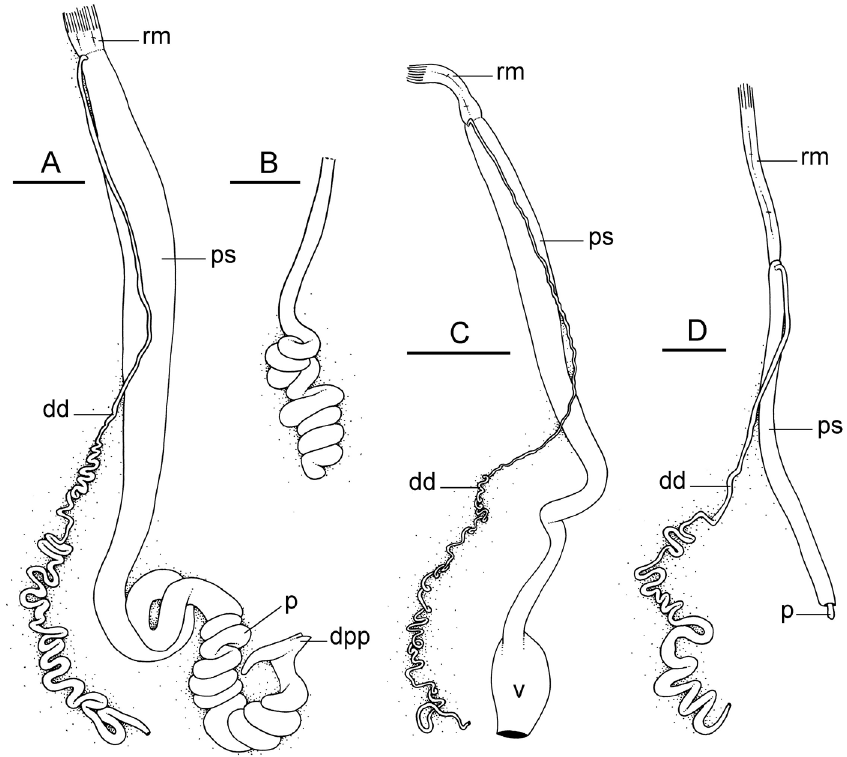
Figure 40. Reproductive system, Wallaconchis ater , Indonesia. A Anterior, male copulatory parts (ves- tibule removed, showing the coiled and U-shaped penis), Halmahera, scale bar 2 mm [5078] (UMIZ 00047) B Penis (coil of loops removed from vestibule), Sulawesi, scale bar 2 mm [2283] (UMIZ 00038) C Anterior, male copulatory parts, scale bar 5 mm, same as B D Anterior, male copulatory parts, Kei Islands, scale bar 1 mm [2939] (UMIZ 00041). Abbreviations: dd deferent duct dpp distal penial projec- tions p penis ps penial sheath rm retractor muscle v